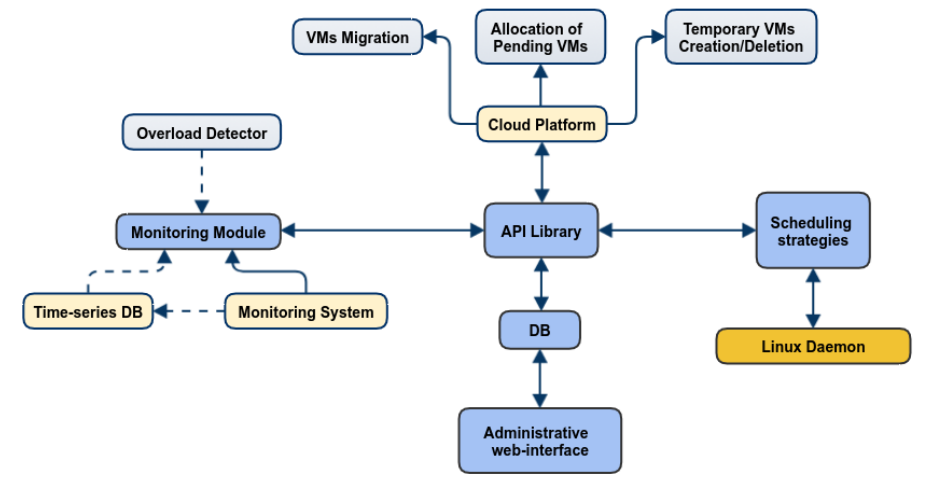
Fig. 4. Main components of the software